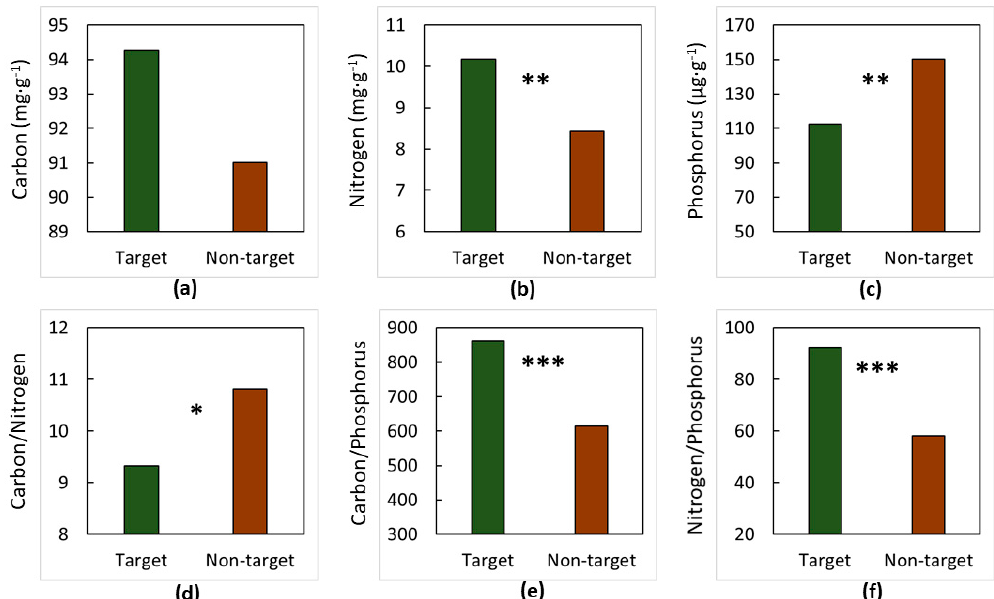
Figure 2. The influence of proximity to Cycas micronesica on soil chemical traits in Guam cobbly clay soils on Guam. Target soils were collected underneath cycad trees. Non-target soils were collected 5-m from focal cycad trees. ( a ) Total carbon; ( b ) Total nitrogen; ( c ) Olsen phosphorus; ( d ) Carbon/nitrogen; ( e ) Carbon/phosphorus; and, ( f ) Nitrogen/phosphorus. *, **, *** = significant at 0.05, 0.01, or 0.001.